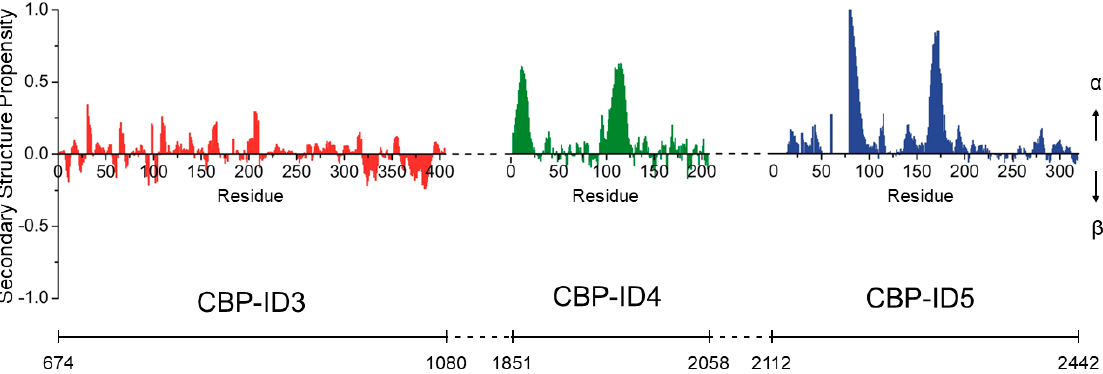
Figure 5. Neighbor-corrected secondary structural propensity (SSP) plots of CBP-ID3 (red), CBP-ID4 (green), and CBP-ID5 (blue) linkers. In the figure, the numbering of each linker has been considered out of the context of the full-length protein while the bottom line reports the corresponding CBP residues’ numbering. The SSP scores were calculated from experimentally measured 15 N H , 13 C’, 13 C α , and 13 C β chemical shifts by using the neighbor-corrected structural propensity calculator [48]. Positive and negative values correspond to α -helical and β -sheet propensities, respectively.